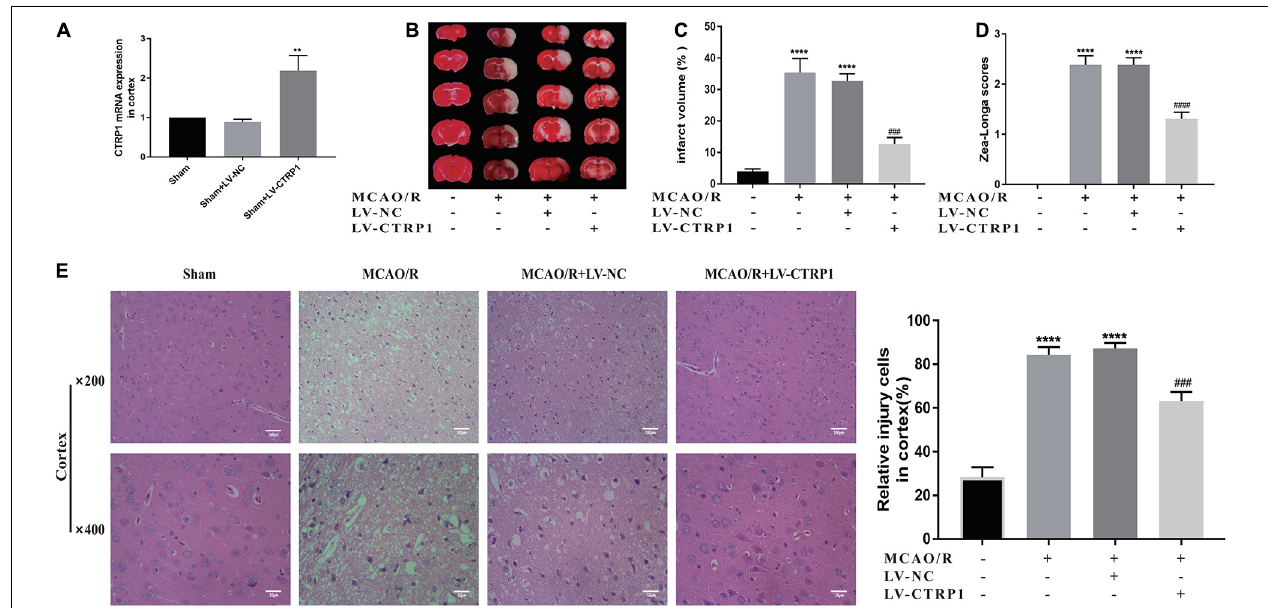
FIGURE 3 | CTRP1 attenuated brain injury in MCAO/R-treated rats. (A) The infection efficiency of LV-CTRP1 in the cortex. n = 3 per group. (B,C) Representative images of TTC staining and quantitative analysis of infarct volume. n = 4 per group. (D) Zea-longe scores. n = 13 per group. (E) HE staining and relative positive cells in the cortex. n = 3 per group. The representative images were acquired under × 400 magnification, scale bars = 50 µ m, × 200 magnification, scale bars = 100 µ m. **** p < 0.0001, vs. sham group, ** p < 0.01 vs. sham + LV-NC group, #### p < 0.0001, ### p < 0.001 vs. MCAO/R + LV-NC group.